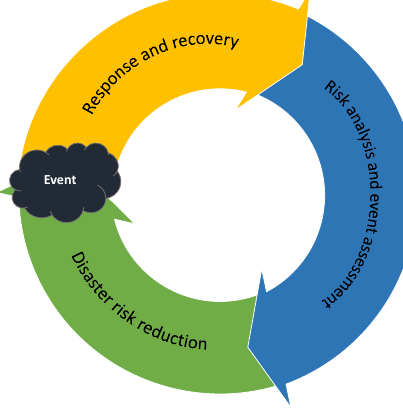
Figure 1. The risk management cycle used as a framework for the exploratory data analyses in this